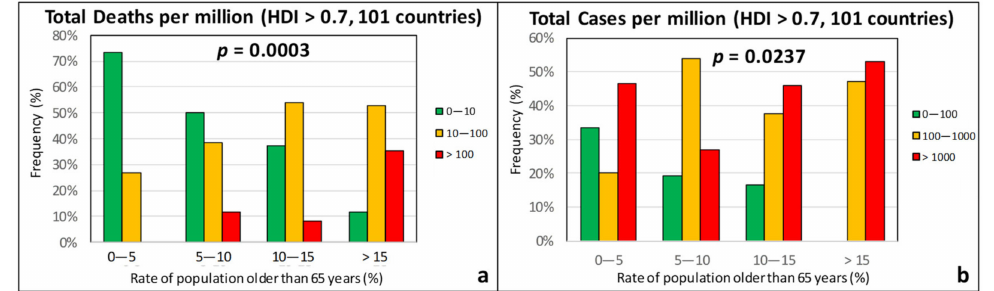
Figure 11. Frequency of ( a ) total deaths per million (green: low, 0–10; orange: moderate, 10–100; red: high, > 100) and ( b ) total cases per million (green: low, 0–100; orange: moderate, 100–1000; red: high, > 1000) as a function of the percentage of population with an age over 65 years for countries with an HDI over 0.7.